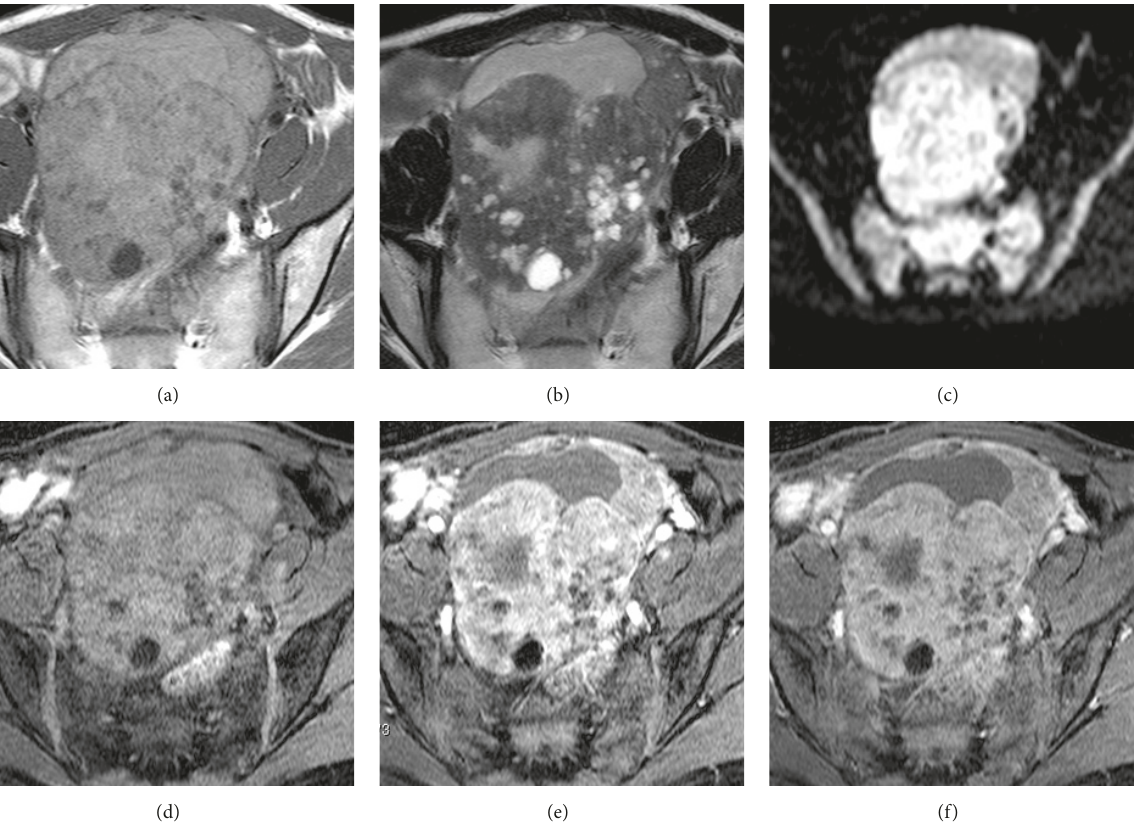
Figure 2: (a) T1-weighted magnetic resonance imaging depicting a mass in the right adnexal region with high signal intensity relative to that of the myometrium. (b) On T2-weighted imaging, the solid component of the mass exhibited slightly low signal intensity, and the large cystic component exhibited high signal intensity. (c) Diffusion-weighted imaging depicting a mass with high signal intensity relative to that of the endometrium. (d) On precontrast fat-saturated T1-weighted imaging, the mass exhibited slightly high signal intensity. (e) On early-phase contrast-enhanced fat-saturated T1-weighted imaging, the mass exhibited strong high signal intensity. (f) On delay-phase contrast-enhanced fat-saturated T1-weighted imaging, the mass exhibited slightly high signal